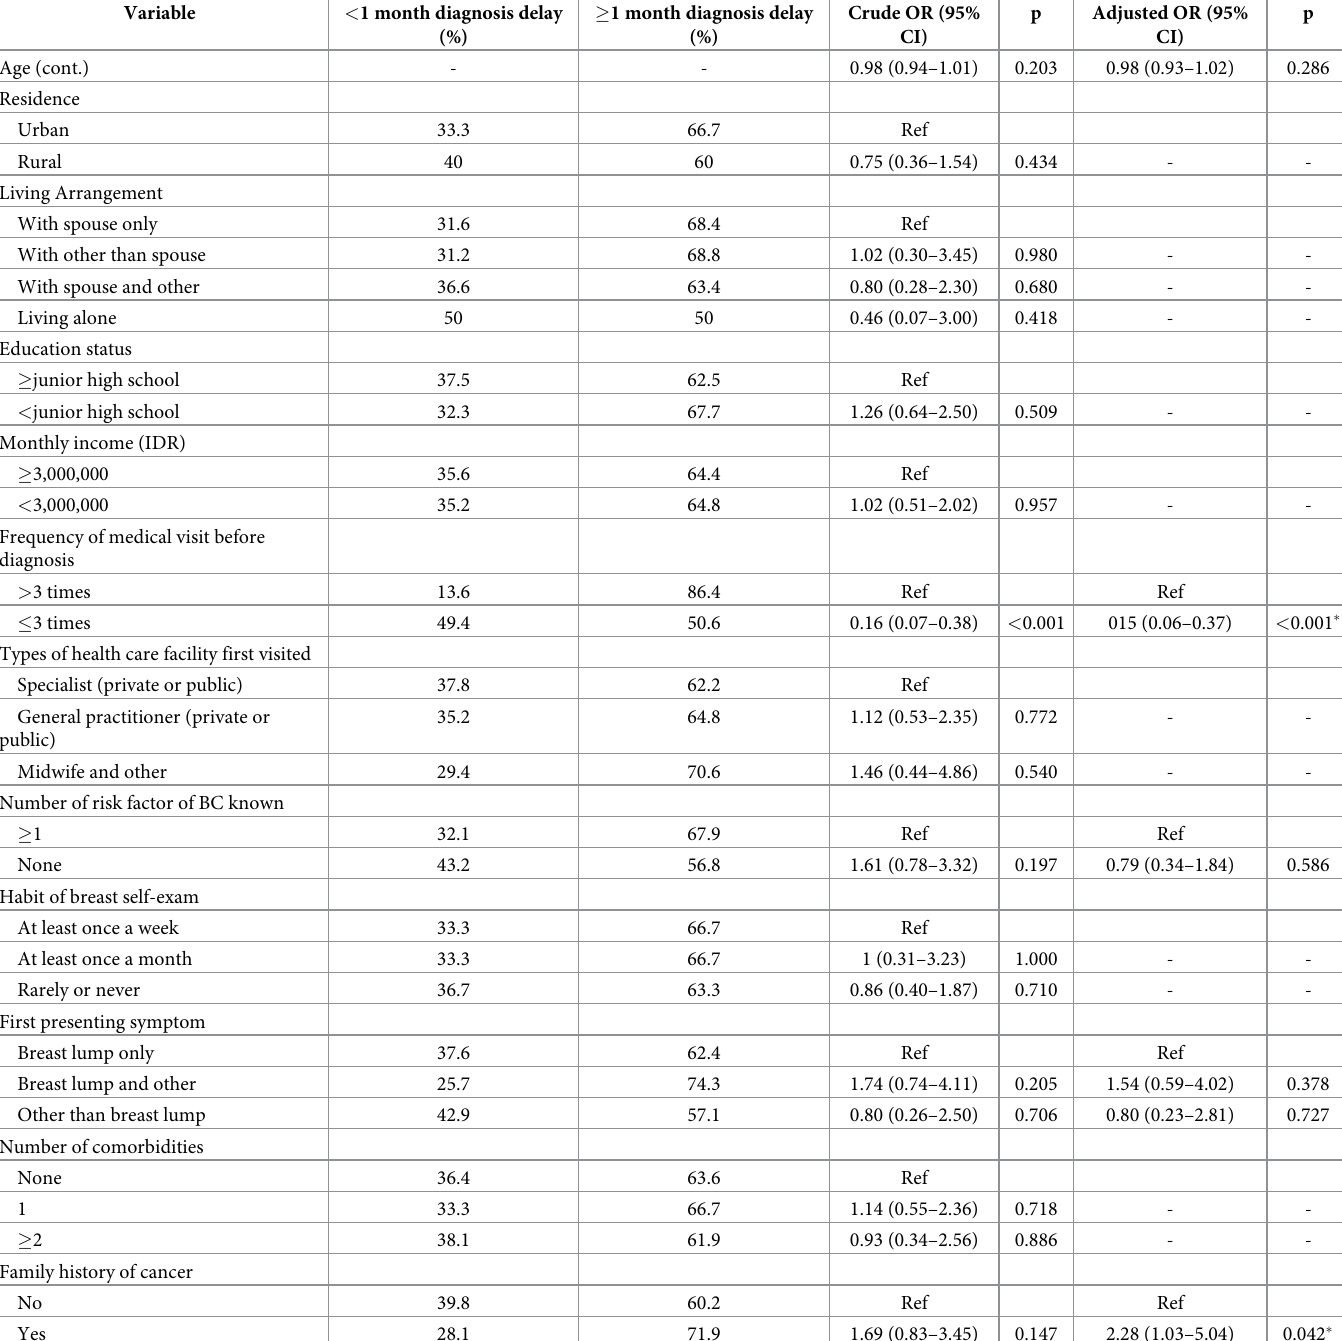
Table 4. Sociodemographic, clinical factors and service utilization associated with � 1 month diagnosis delay in breast cancer patients.